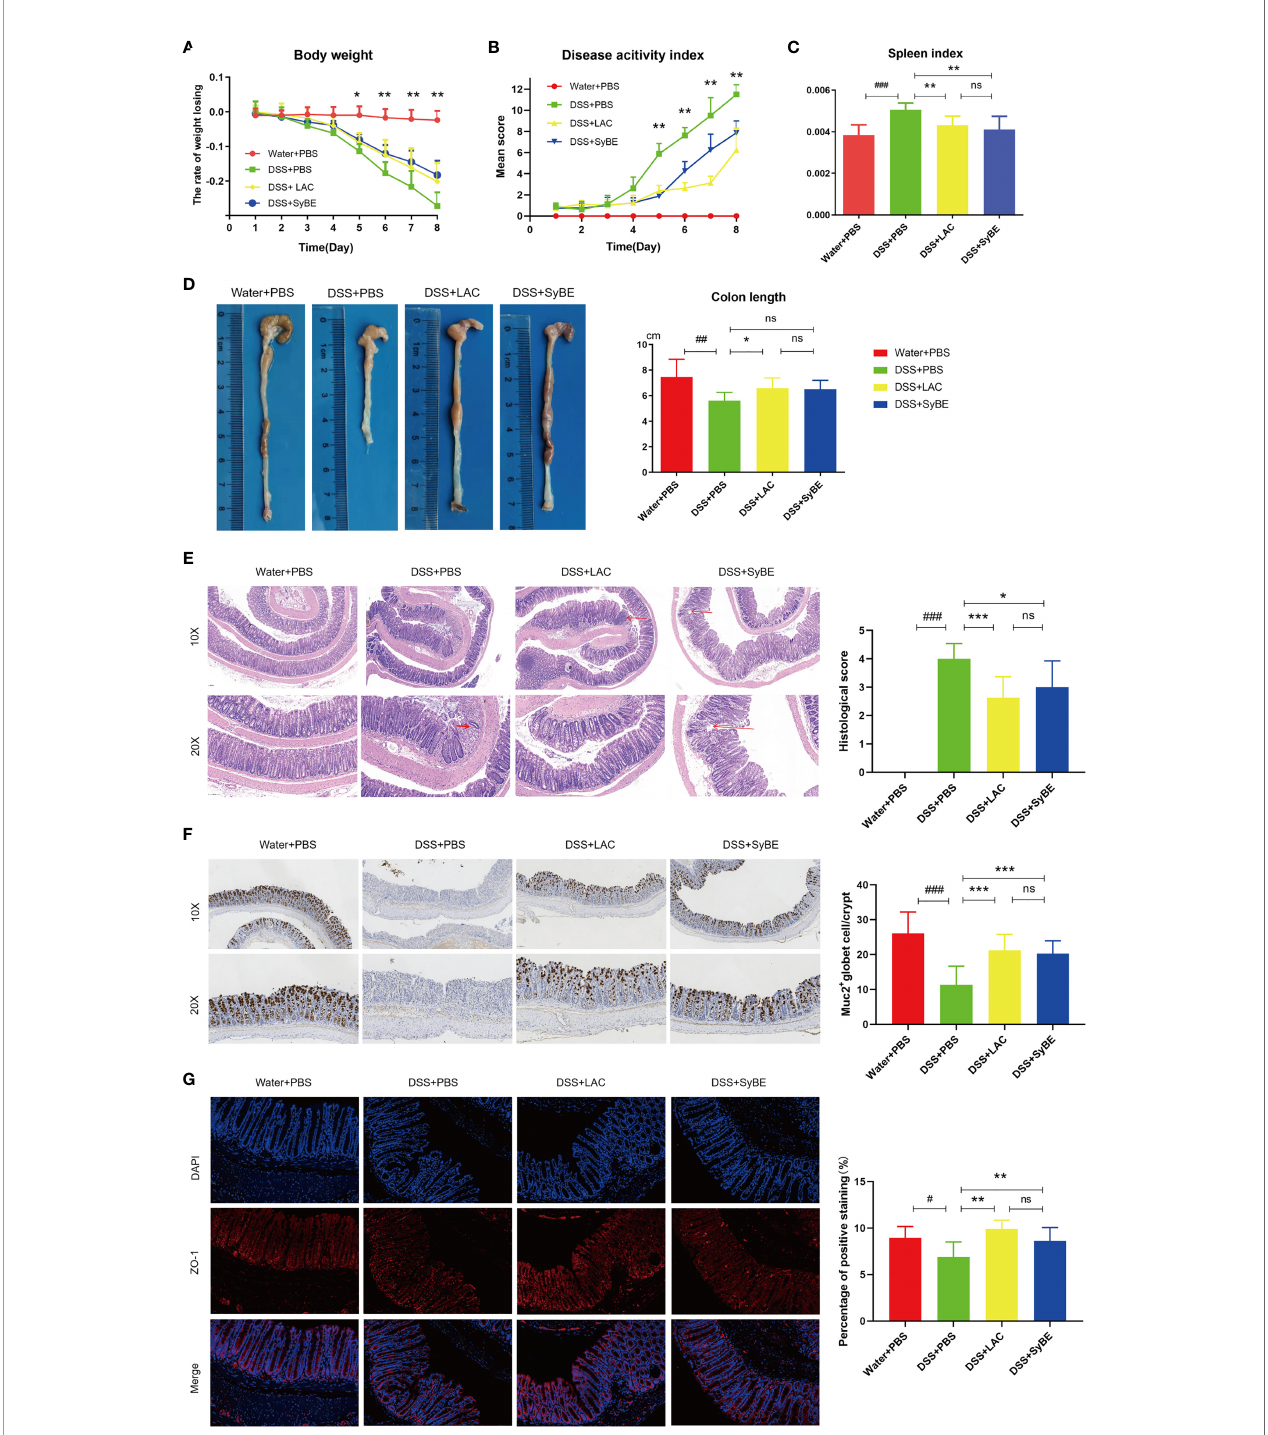
FIGURE 2 | Effects of lactic acid and lactic acid-producing Saccharomyces cerevisiae on dextran sulfate sodium (DSS)-induced mouse colitis. (A) The body weight of mice was evaluated in the experiment. (B) The disease activity index was measured daily. (C, D) The spleen index and colon length were measured. (E) The distal colon was stained with hematoxylin and eosin to determine the degree of in fl ammation. (F) Immunohistochemistry stain against MUC2. (G) Immuno fl uorescent staining against ZO-1 in colon. Statistical analysis was performed using one-way ANOVA, with comparison with the DSS group mice. The results are based on eight mice per group. Error bars represent standard errors. Values represent the mean ± SD of the mean. # p < 0.05, ## p < 0.01, ### p < 0.001 vs. the Water+PBS group; * p < 0.05; ** p < 0.01; *** p < 0.001 vs. the DSS+PBS group. ns, no signi fi